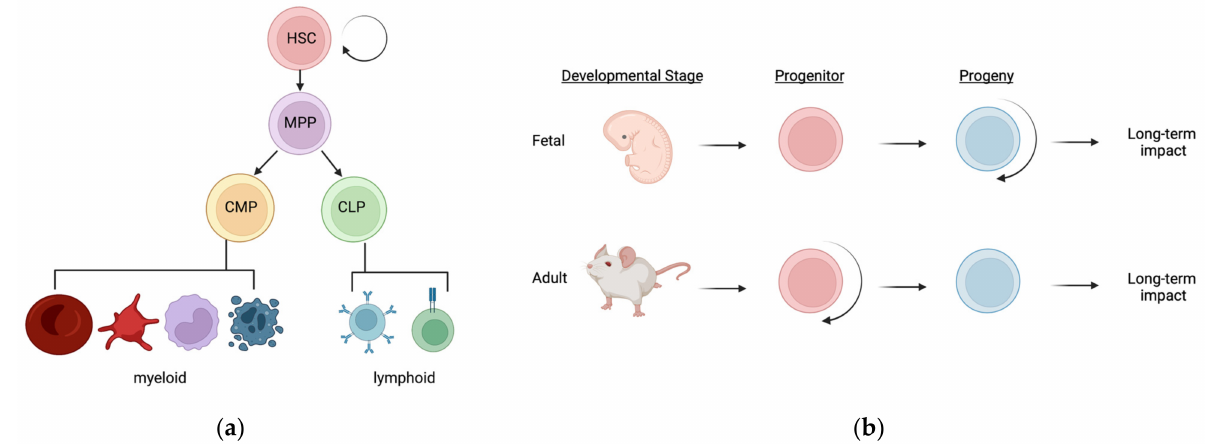
Figure 1. The hematopoietic hierarchy and sources of potential long-term impacts following nicotine exposure: ( a ) Hematopoiesis is the process of generating all mature blood and immune cells from hematopoietic stem cells (HSCs). This process occurs in a well-defined hierarchy during adult steady- state hematopoiesis, as depicted in this simplified tree structure. HSCs differentiate into multipotent progenitors, and then either common myeloid progenitors (CMPs) or common lymphoid progenitors (CLPs), before terminally differentiating into mature blood and immune cells of either myeloid or lymphoid classification. HSCs are unique in their ability to both self-renew as well as differentiate into all of these progenitors and mature cells; ( b ) During fetal hematopoiesis, distinct waves of hematopoietic stem and progenitors (HSPCs) exist throughout development and adulthood. Many of the progenitors that exist during early fetal development are non-self-renewing but can give rise to self-renewing progeny such as “non-traditional” tissue-resident immune cells. Subsequently and during adult steady-state, hematopoiesis is sustained by self-renewing progenitors (HSCs) that give rise to non-self-renewing, short-lived progeny such as “traditional” circulating RBCs and WBCs. Nicotine exposure may influence life-long immunity by two potential mechanisms: (1) nicotine causes changes or persistence in HSPCs which results in altered hematopoietic output for life, or (2) nicotine causes a change in the long-lived immune cells during their establishment which alters immunity later in life. These mechanisms are not mutually exclusive and a combination of both could lead to altered hematopoiesis and altered immunity for life. Adapted from Cool and Forsberg, 2019